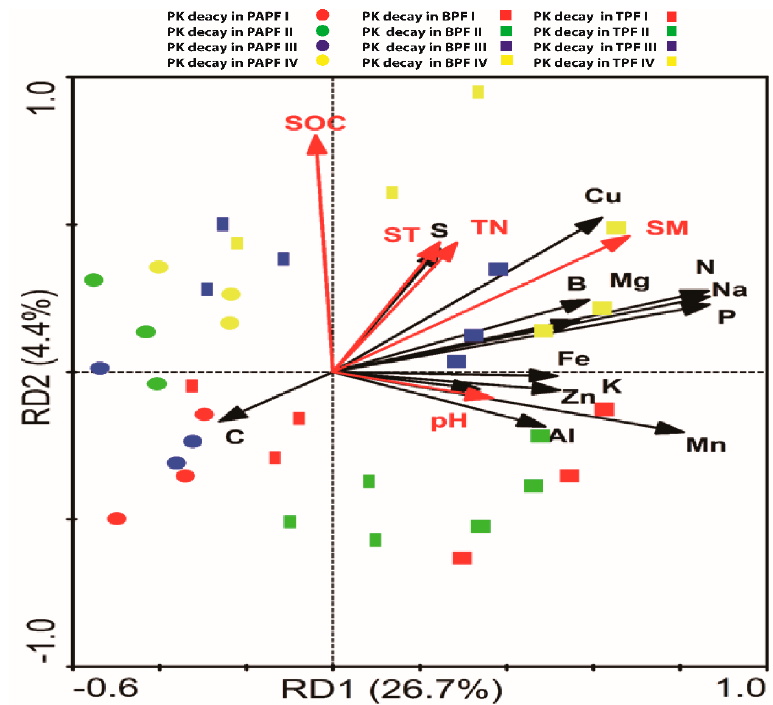
Figure 2. Redundancy analysis for nutritional status of the decay classes of contrasting forest types of Picea koraiensis-Abies nephrolepis-Pinus koraiensis forest (PAPF), Betula costata-Pinus koraiensis forest (BPF), and Tilia amurensis-Pinus koraiensis forest (TPF) in Northeastern China. Abbreviations: Al: